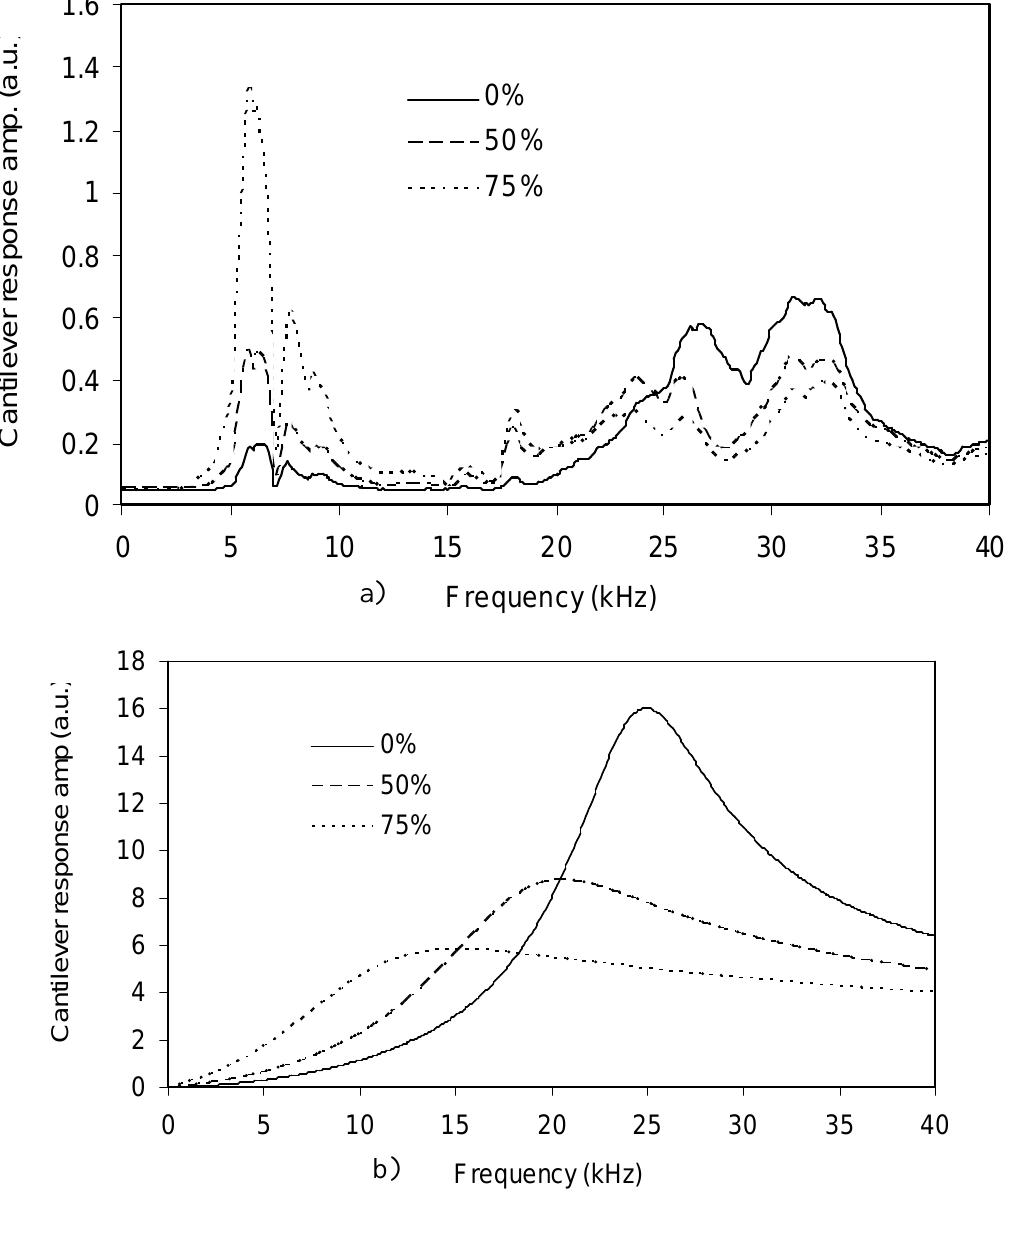
Figure 7. Response of cantilever 4 in three solutions of glycerin and water; a) measured by AFM optics, b) determined